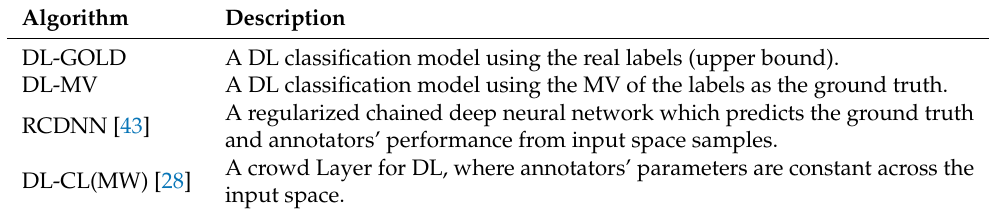
Table 2. A brief overview of the state-of-the-art methods